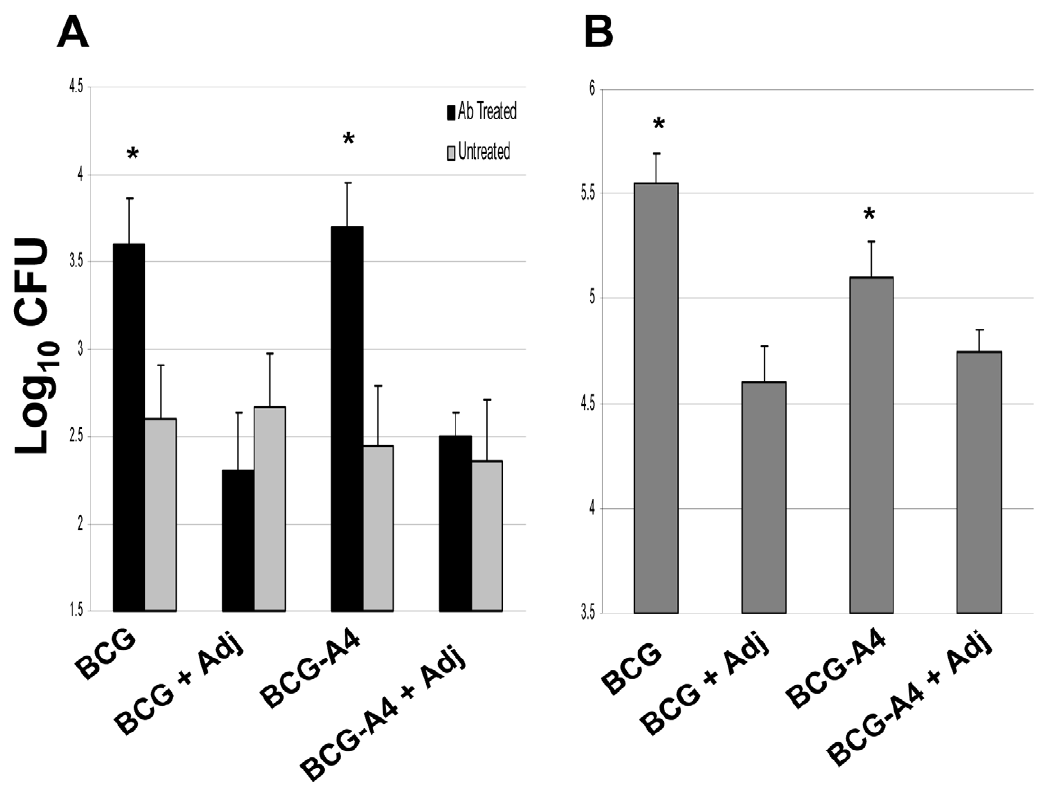
Figure 6. Reduced BCG splenic CFU levels one month after treatment of immunocompromised mice with the adjuvanted BCG preparations. A. Mice were given two i.p. injections of anti-IFN c mAb (black bars) two days apart before receiving a single 10 6 CFU dose of either BCG or D mmaA4 BCG with or without adjuvant. Untreated mice served as infection controls (gray bars). The antibody treatment was repeated every 10 days until the mice were sacrificed one month post-infection to quantify the splenic BCG CFU. B. SCID mice were injected with a single 10 6 CFU dose of either BCG or D mmaA4 BCG with or without adjuvant. One month after the injection, splenic bacterial burdens were determined. *Significant differences relative to adjuvanted BCG controls, p ,